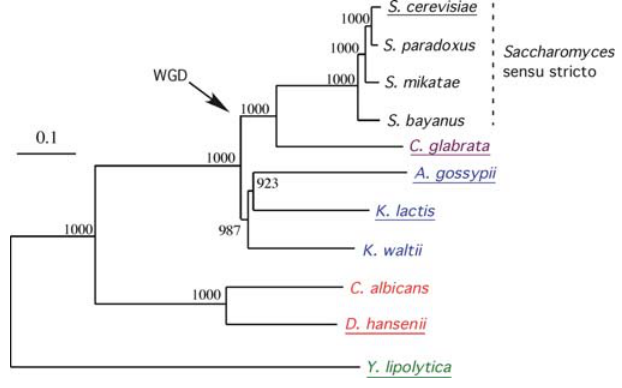
Figure 1. Phylogeny of Hemiascomycete